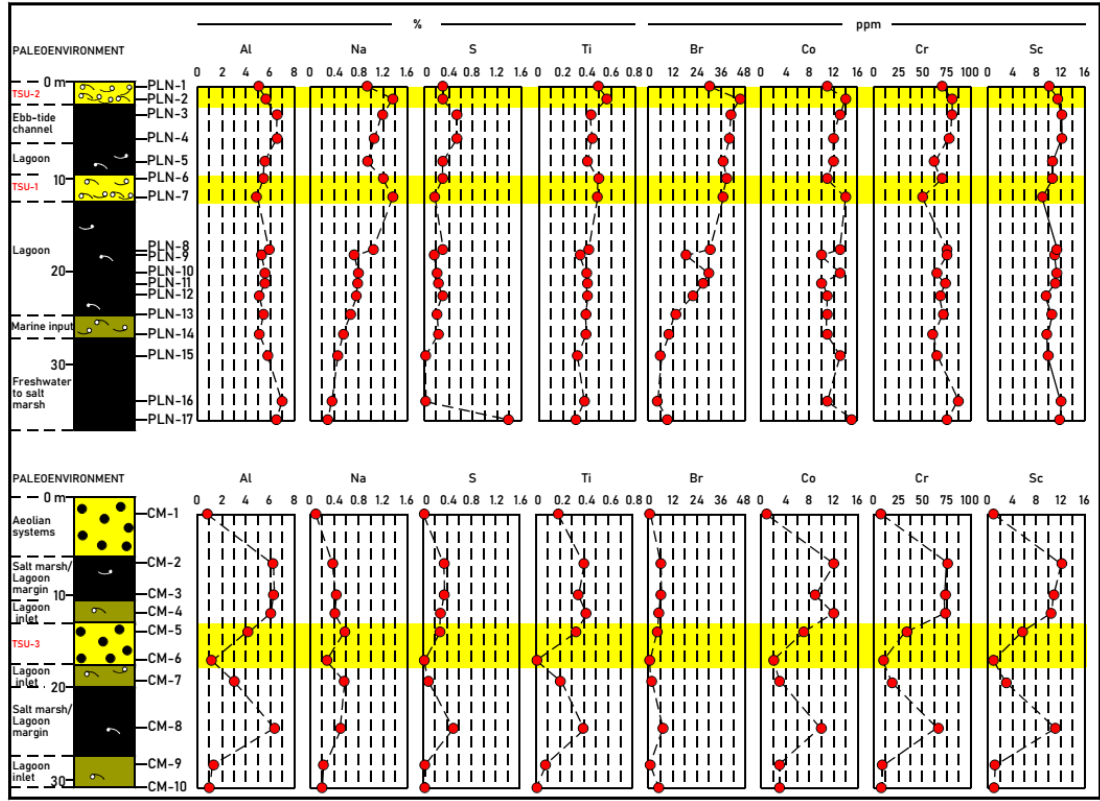
Figure 6. Vertical variations of other elements (%: Al, Na, S, Ti; ppm: Br, Ce, Cr, Sc). The detection limits are 0.01% (Al), 0.01% (Na), 0.01% (S), 0.5 ppm (Br), 1 ppm (Co), 2 ppm (Cr) and 0.1 ppm (Sc).